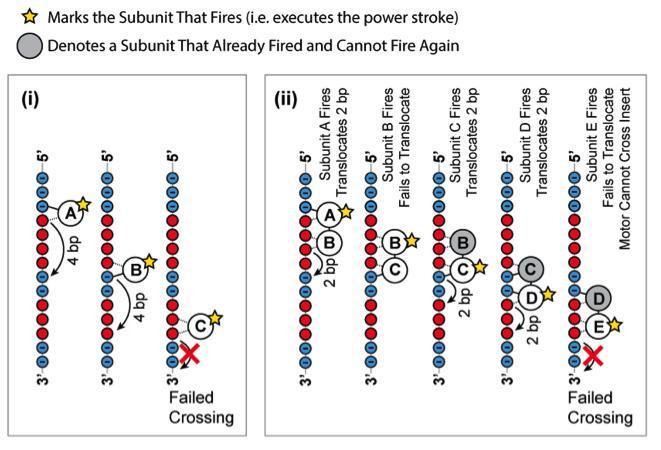
DOI:
http://dx.doi.org/10.7554/eLife.09224.015